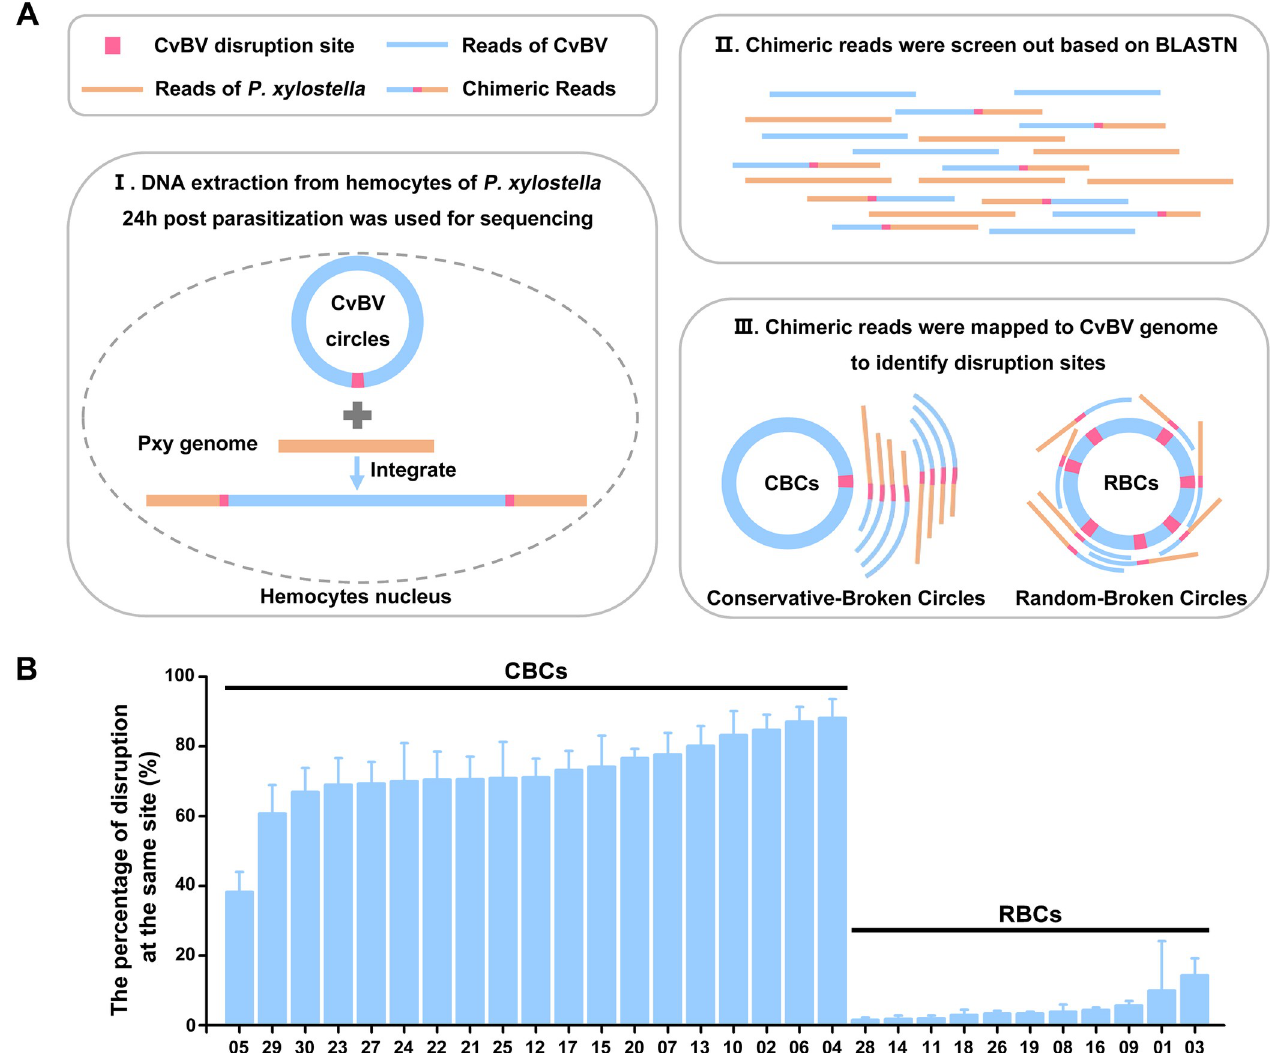
Fig 2. CvBV circles are disrupted in two distinct modes. A : Schematic diagram of identifying the disruption sites of CvBV circles. Step I: DNA was extracted from hemocytes of caterpillar hosts 24 h p.p. The DNA used for sequencing consists of CvBV DNA, P . xylostella DNA and P . xylostella DNA with integrated CvBV DNA. Step II: Chimeric reads containing both nucleotides of CvBV and P . xylostella sequences were sorted out based on BLASTN. Step III: Chimeric reads were then mapped to CvBV genome to identify the fractured sites. Two modes of disruption were found for CvBV circles, which included Conservative- Broken Circles (CBCs) and Random-Broken Circles (RBCs). B : The ratios of a conserved disruption site for CBCs and RBCs during integration. The abscissa represents different circles of CvBV, and the ordinate represents the percentage of disruption at the same site.